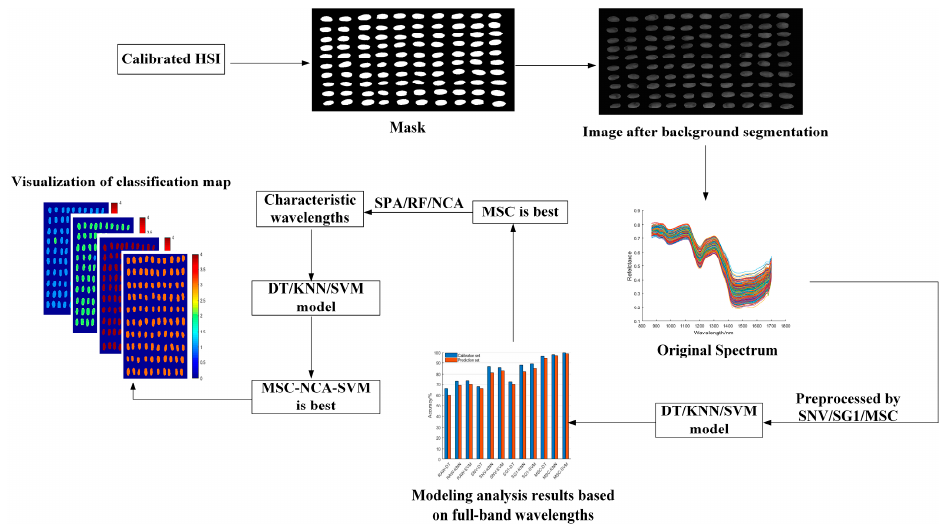
Figure 2. Main steps of extracting spectral information, characteristic wavelength, and establishing discrimination